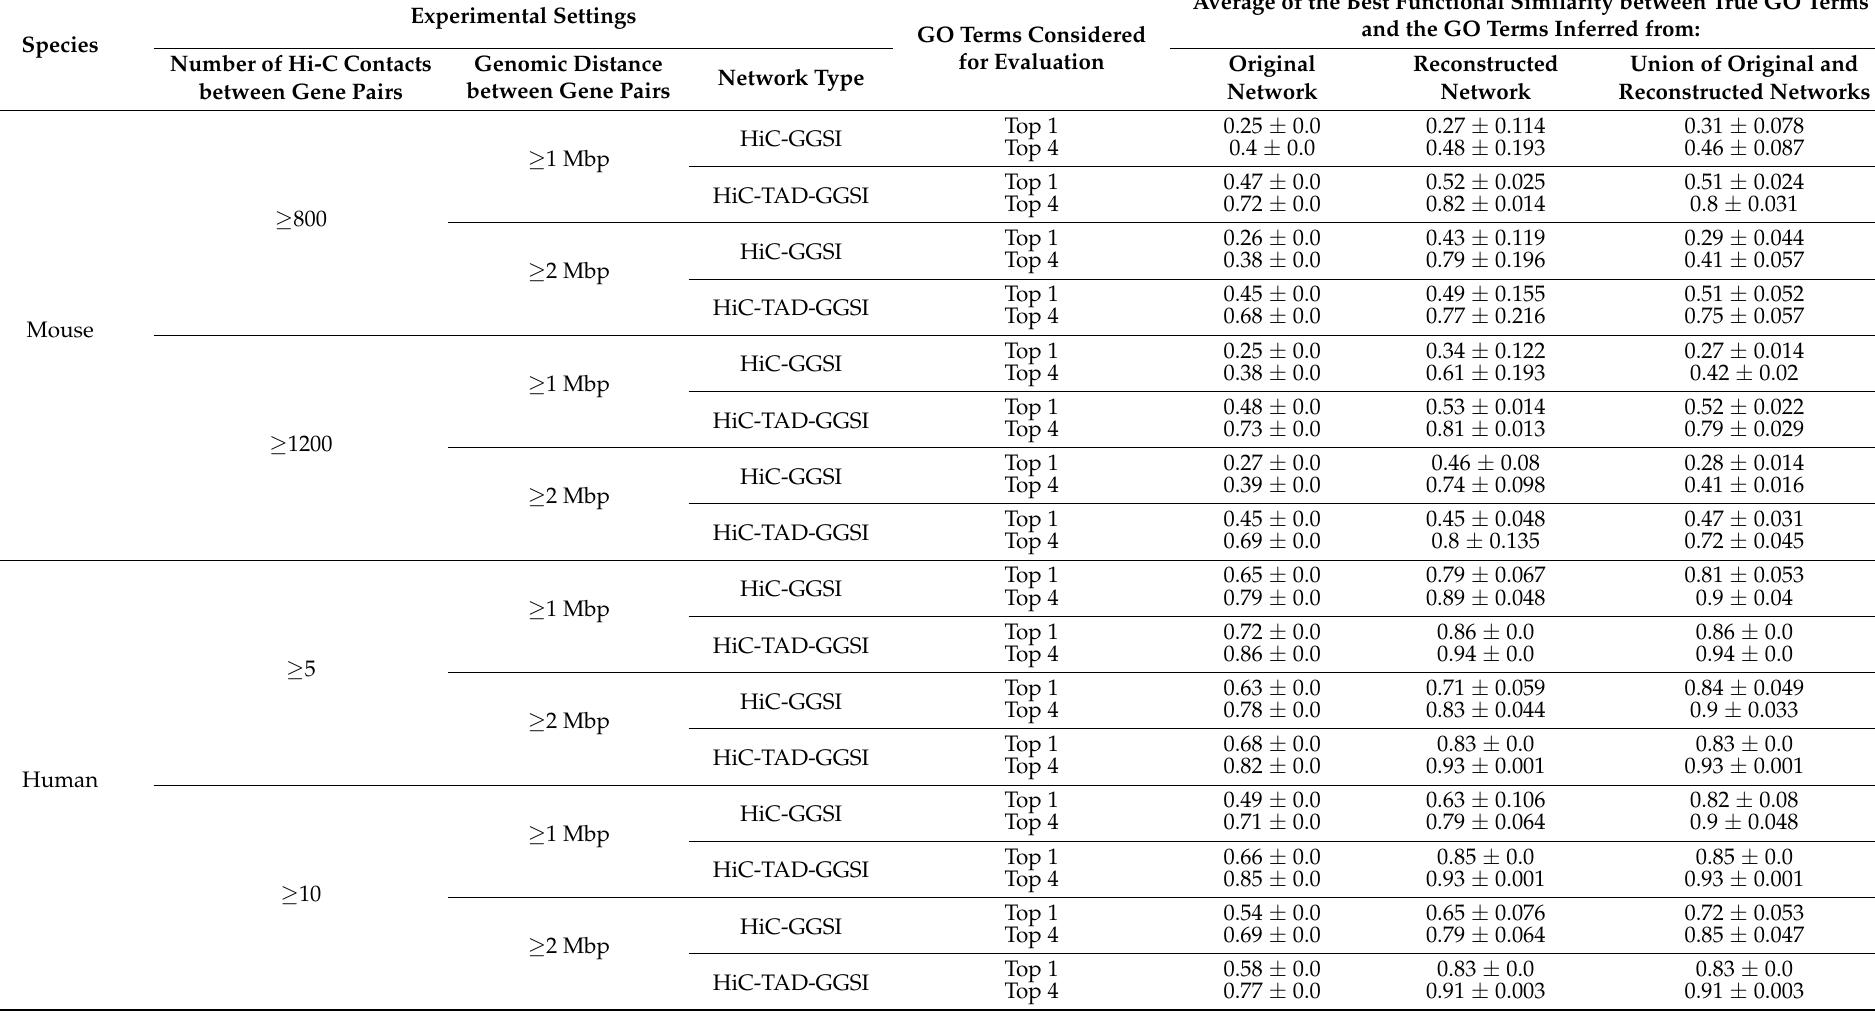
Table 3. Performance of function prediction based on the reconstructed networks on the X-chromosomes of the mouse, human, and chimpanzee. We calculated the 95% confidence interval with ten repeated